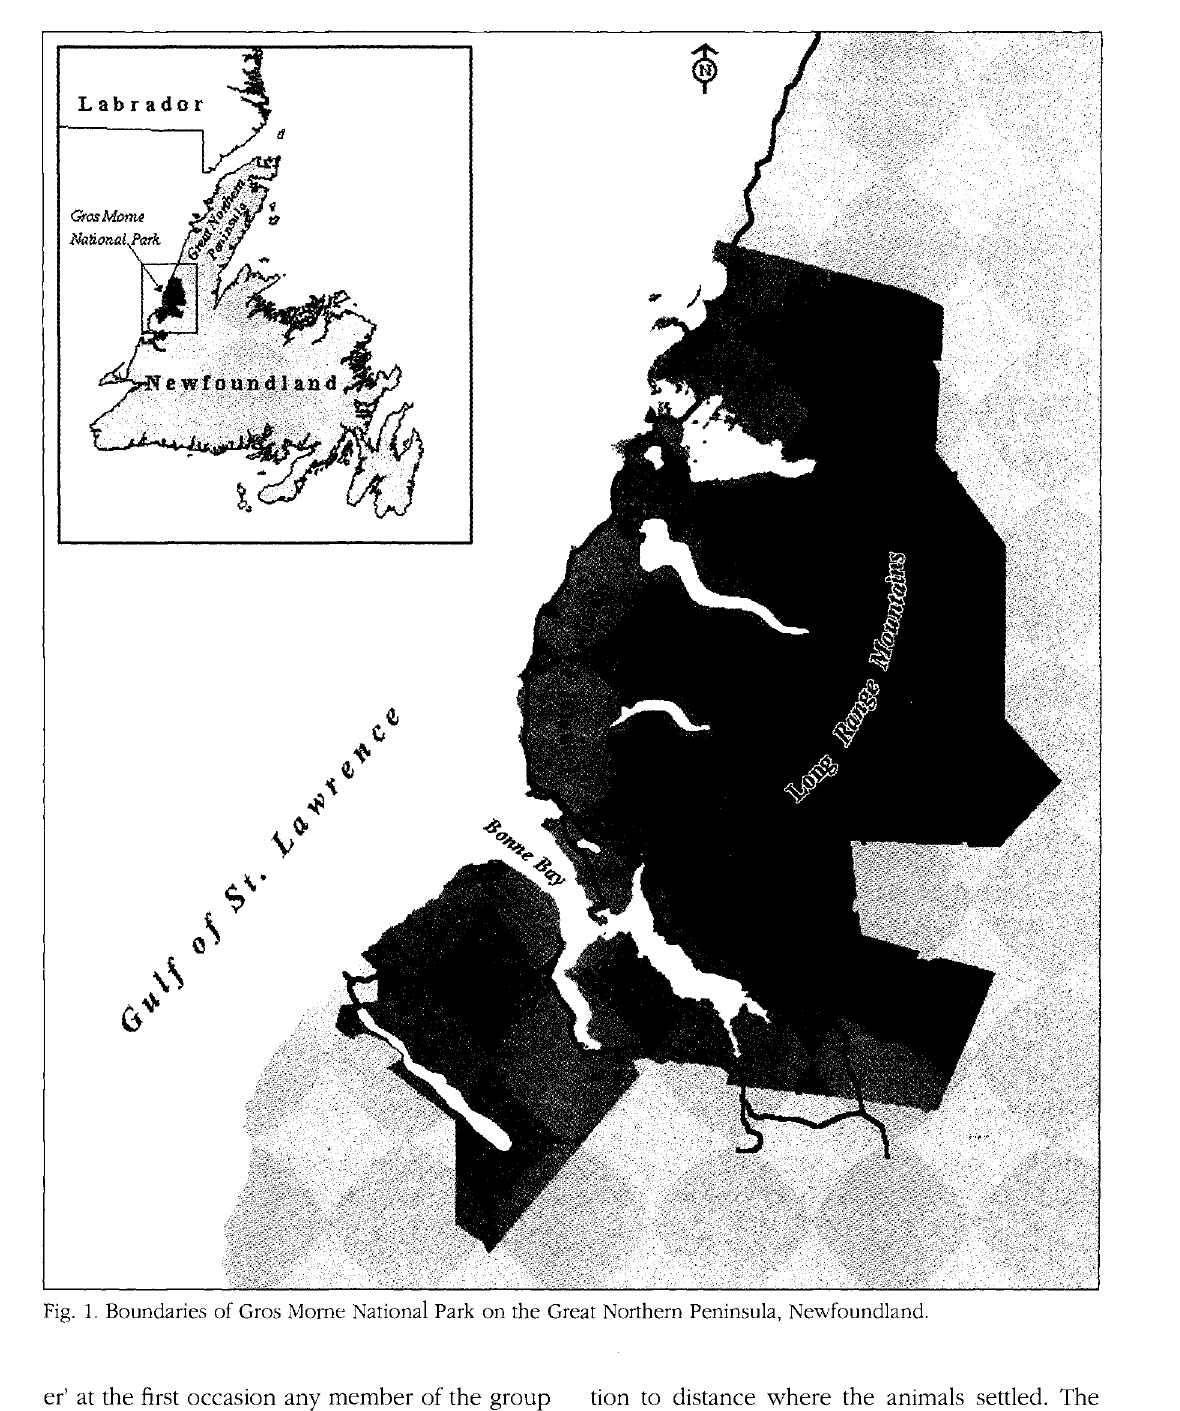
er' at the first occasion any member of the group showed any sign of unease or alarm; (iii) dis tance at initial flight; distance between a group of caribou and the 'attacker' at the instant the ani mals first fled; and (iv) net distance of flight: dis tance from the 'attacker' at the start of provoca- Rangifer, 21 (1), 2001